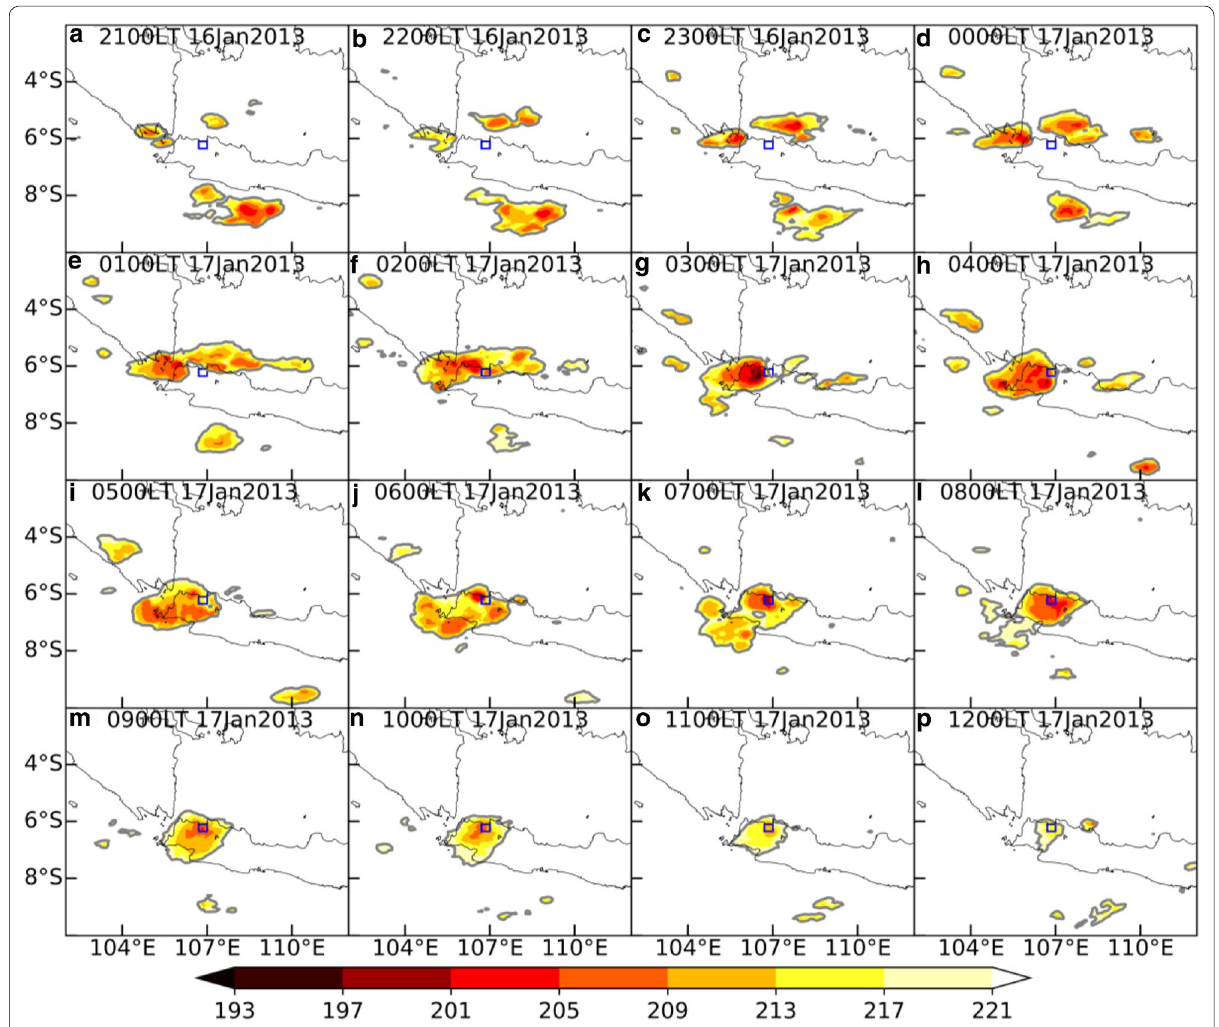
The mechanisms of MCS development The Cengkareng radar constant altitude point posi- tion indicator (CAPPI) of reflectivity displays at 2 km altitude from volume scans at 00:00 LT on 15 January 2013 (Fig. 7a) and 02:00 LT on 17 January 2013 (Fig. 7c) depicts the horizontal structure of MCS development in GJ. The vertical structure at dashed line crosses over GJ at 00:00 LT on 15 January 2013 (Fig. 7b) and 02:00 LT on 17 January 2013 (Fig. 7d). Vertical cross sections